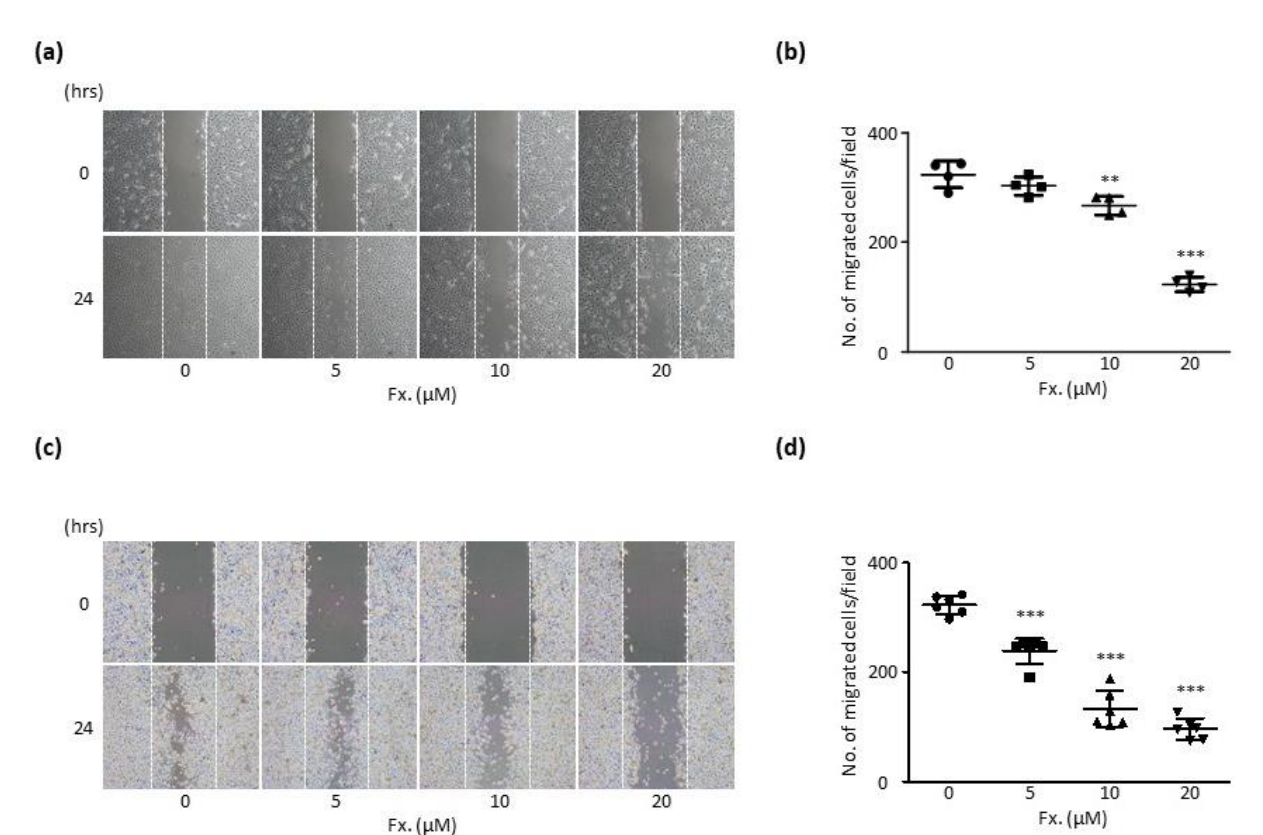
Figure 4. Fucoxanthin decreases the cell migration in HUVECs and CMT-U27 cells. ( a , c ) Images showing HUVEC ( a ) and CMT-U27 cell ( c ) migration after fucoxanthin (0, 5, 10, and 20 μM) for 24 h. Magnification, 40×. ( b , d ) Quantification of HUVEC ( b ) and CMT-U27 cell ( d ) migration from ( a , c ), respectively. Fx., Fucoxanthin. Values are presented as the mean ± SD of three independent experiments. ** p < 0.01, *** p < 0.001.